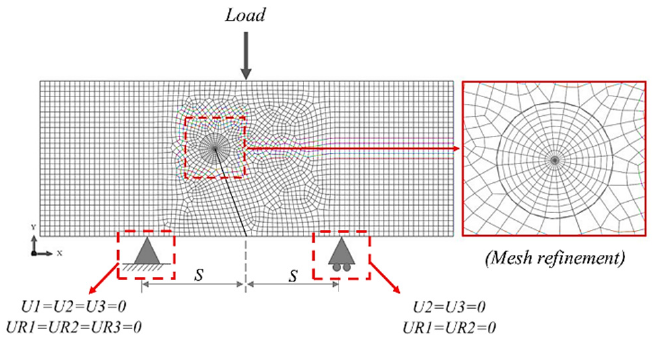
Figure 2. Finite element analysis model of the ICB specimen.